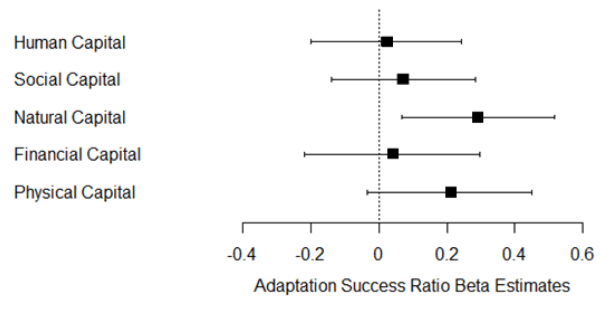
Fig. 4. Plot showing the model-averaged beta estimates for each type of capital for the adaptation success ratio.